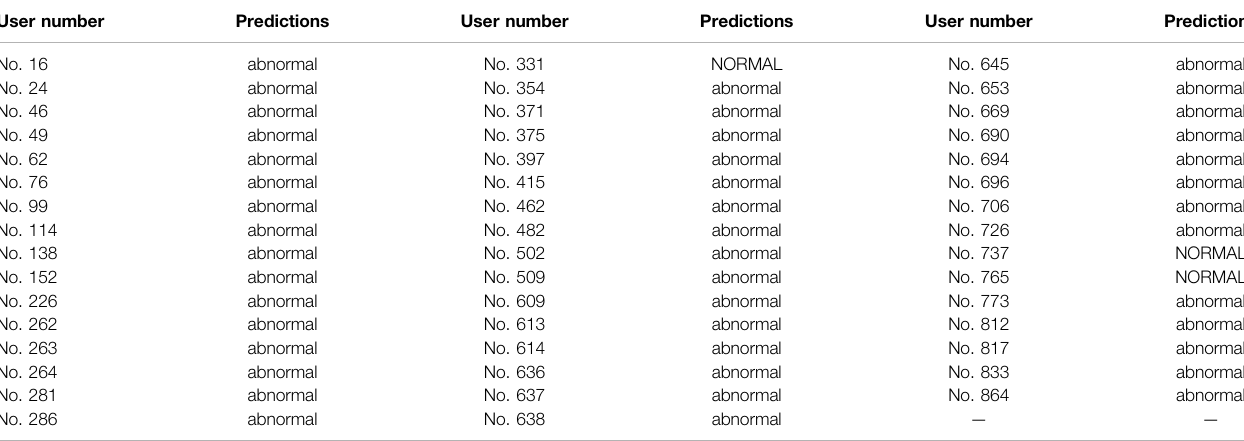
TABLE 4 | Discrimination results for the 47 real abnormal data of the electricity theft